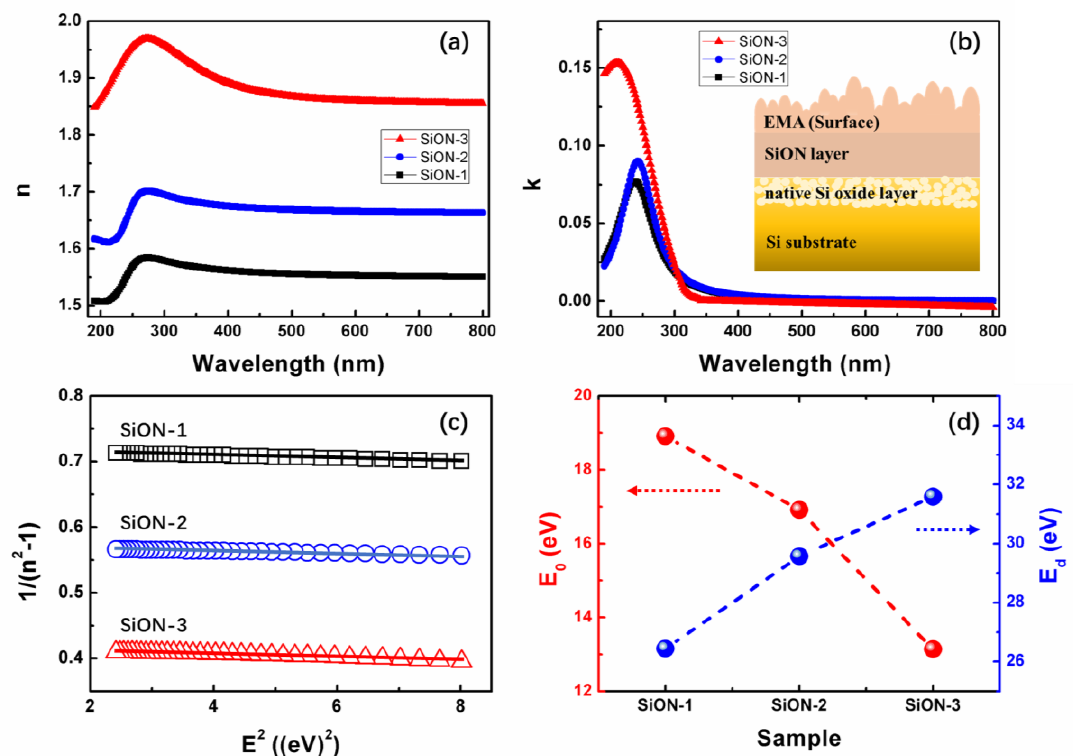
Figure 8. ( a ) Refractive index and ( b ) extinction coefficient of SiON thin film as a function of the wavelength. The inset in ( b ) displays the schematic representation of the layer structure employed to model the experimental data. ( c ) Dependence of 1/( n 2 − 1) as a function of square photon energy obtained from SE (symbols) and linear fit of this data (solid lines) according to Wemple-DiDomenico model [43]. ( d ) Parameters E 0 and E d for different SiON